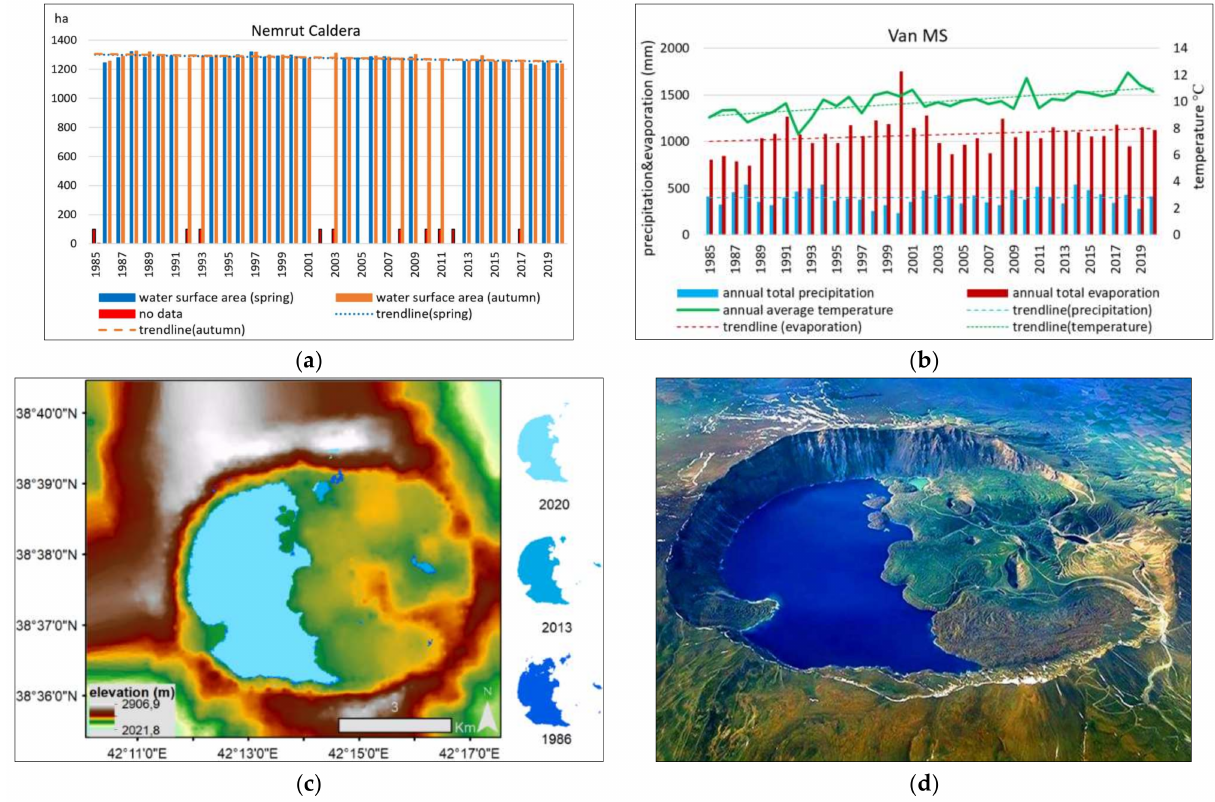
Figure 9. Nemrut Caldera: ( a ) 1985–2020 annual (spring and autumn) surface water areas; ( b ) representative meteorological station data (precipitation, evaporation, and temperature); ( c ) water surface area changes (NDWI); ( d ) view of the site